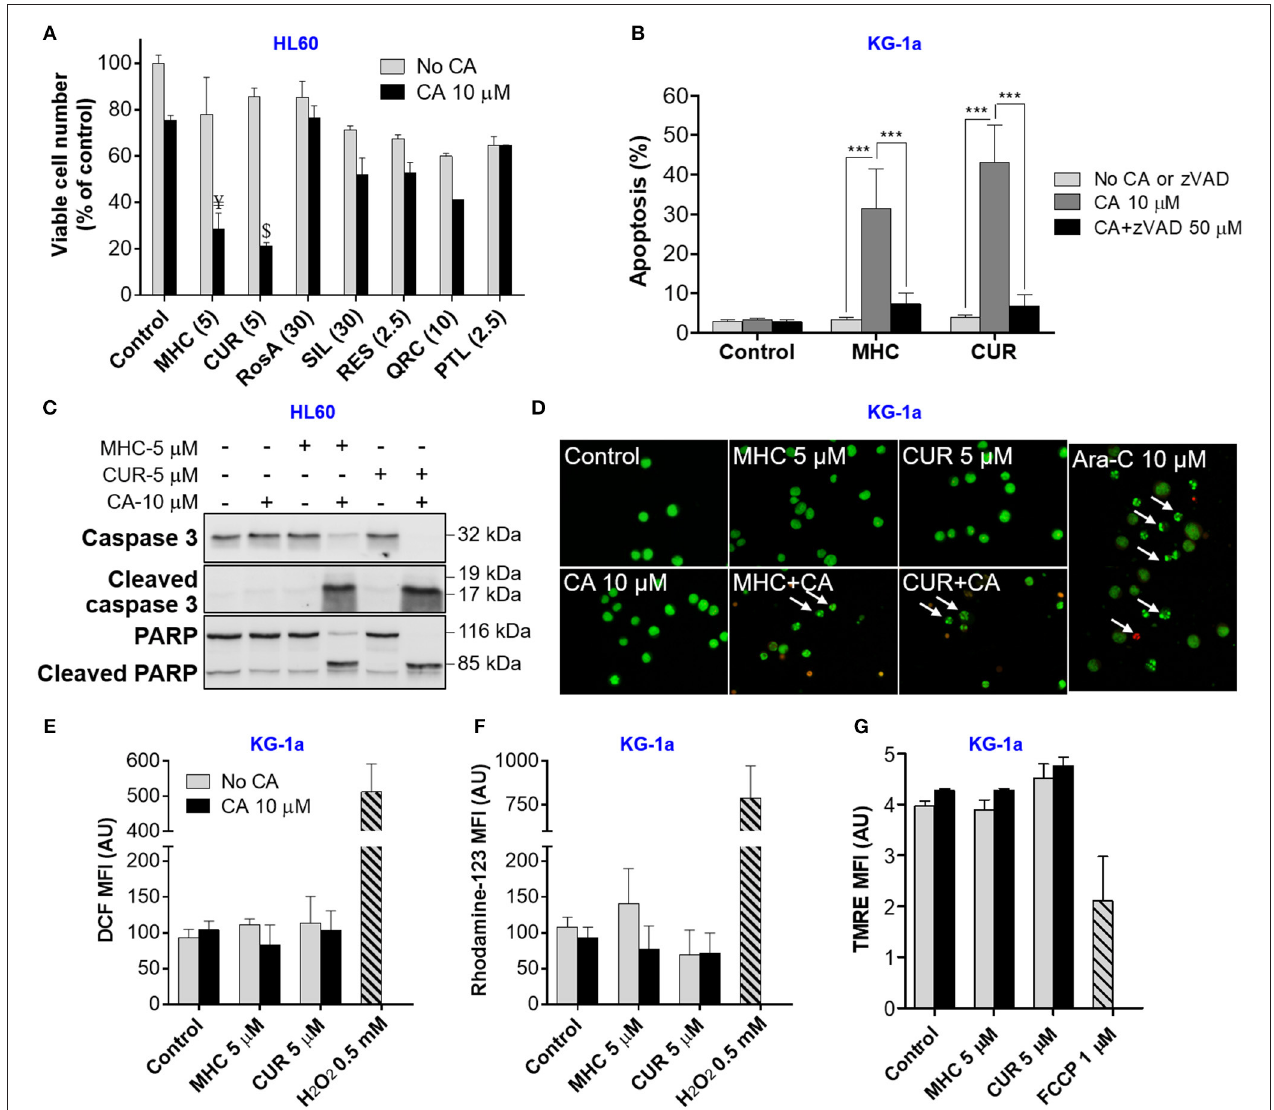
FIGURE 1 | MHC is similar to CUR in the ability to synergize with CA in inducting anti-leukemic effects on AML cells. (A) Changes in viable cell numbers. HL60 cells were treated with different phenolic compounds (in µ M): CUR, MHC, rosmarinic acid (RosA), silibinin (SIL), resveratrol (RES), quercetin (QRC), parthenolide (PTL) and/or 10 µ M CA, for 72h. Viable cell numbers were determined by the trypan blue exclusion assay. The data are the means ± SD ( n = 3). (B) Apoptosis induction. KG1a cells were treated for 8h in the presence or absence of zVAD (50 µ M). The extent of apoptosis was determined by the annexin V/PI binding assay. (C) Western blot analysis of caspase-3 and PARP cleavage in HL60 cells treated with MHC or CUR with or without CA, for 24h. (D) Changes in nuclear morphology. KG-1a cells were treated with the indicated compounds, for 8h, followed by staining with acridine orange (green fluorescence) and ethidium bromide (red fluorescence). Stained cells were examined under fluorescence microscope at 400x magnification. Cells treated with 10 µ M Ara-C, for 8h, were used as the positive control. Arrows indicate late apoptotic cells and/or apoptotic bodies. (E,F) Assessment of the intracellular ROS. KG-1a cells were treated with the indicated compounds, for 4h, followed by loading with DCFH 2 -DA (E) or DHR (F). DCF and rhodamine-123 fluorescence was measured by flow cytometry. Averaged geometric means of fluorescence intensities (MFI) ± SD from three independent experiments are shown. H 2 O 2 (0.5mM) was used as the positive control. (G) Assessment of the mitochondrial membrane potential. KG-1a cells were treated with the indicated compounds, for 2h, followed by loading with TMRE. Averaged MFI ± SD were measured in 3 independent experiments. The uncoupler FCCP (1 µ M, 10min) was used as the positive control. Synergistic effect (AB > A + B): U , p < 0.05; $, p < 0.01; Student’s t -test. AU, arbitrary units. (B) *** p < 0.001; one-way ANOVA with Tukey multiple comparison post-hoc analysis.